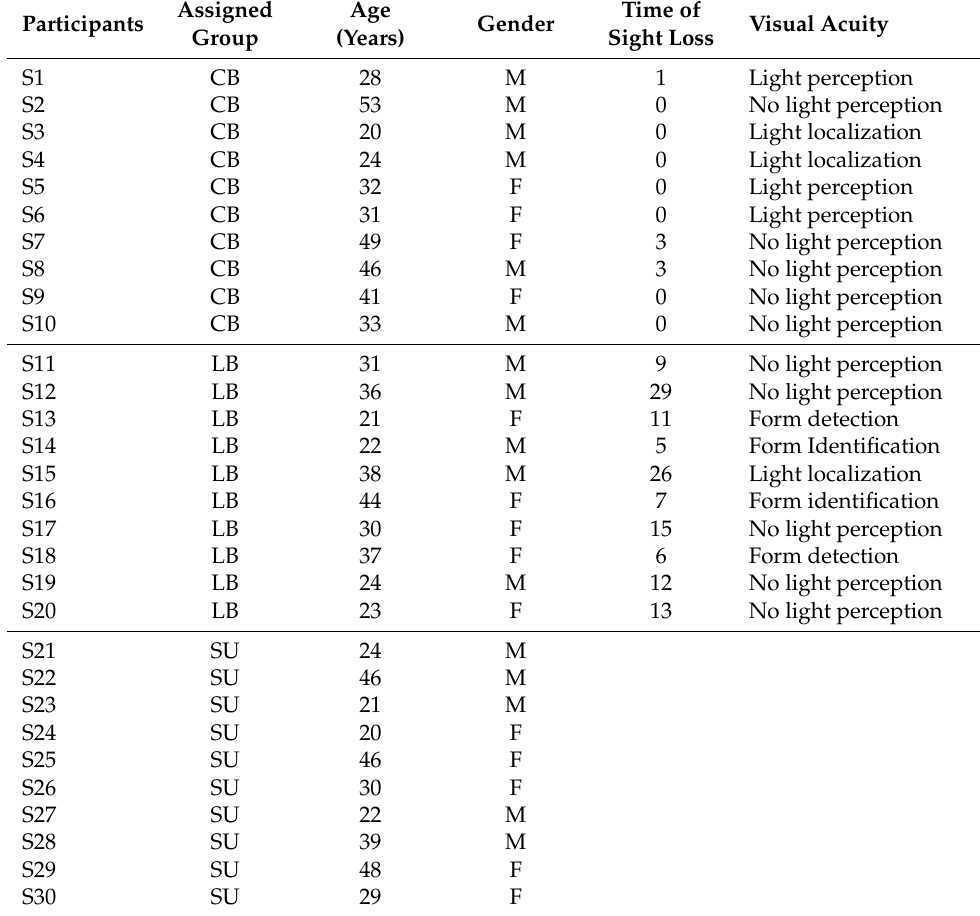
Table 1. Demographic information of participants for preliminary